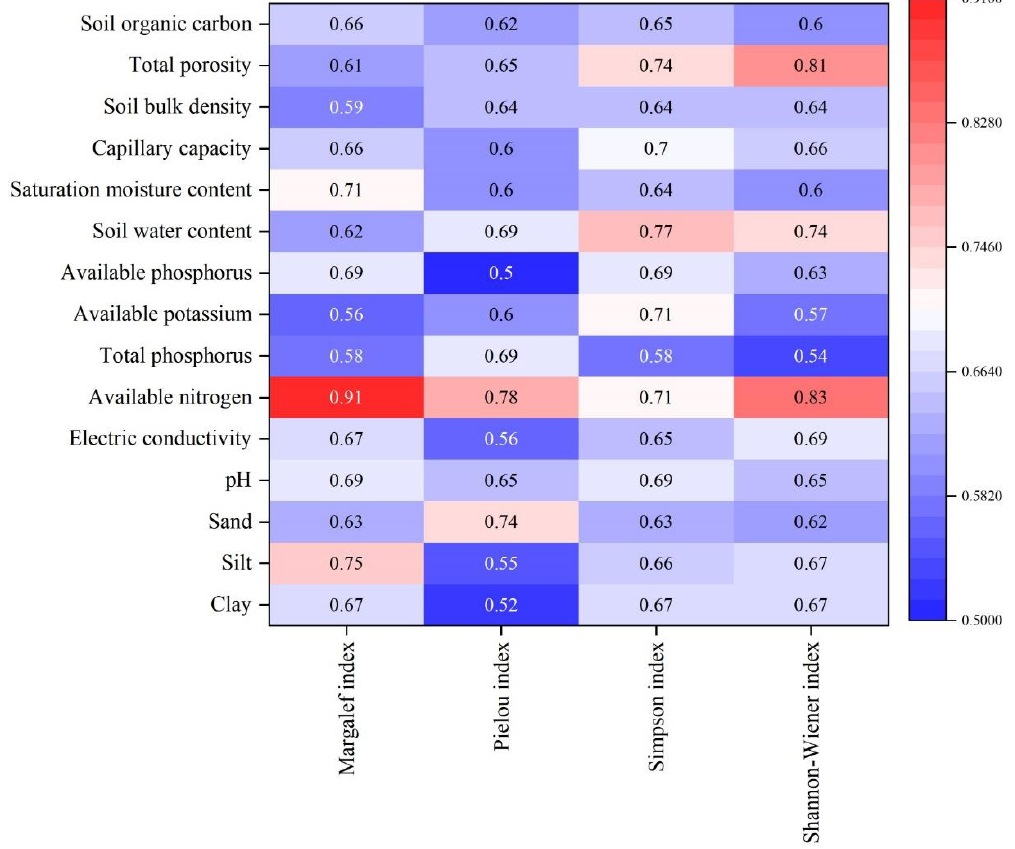
Figure 3. Coupled heat map of herbaceous community diversity and soil.